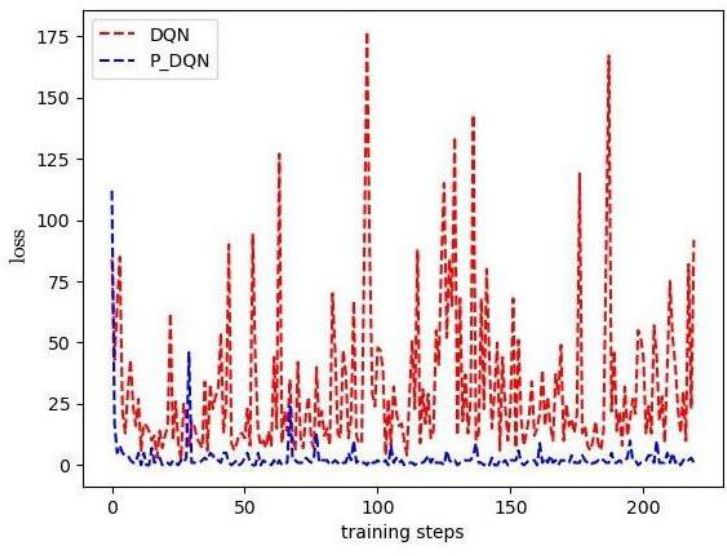
Figure 12. Comparison of convergence results before and after priority